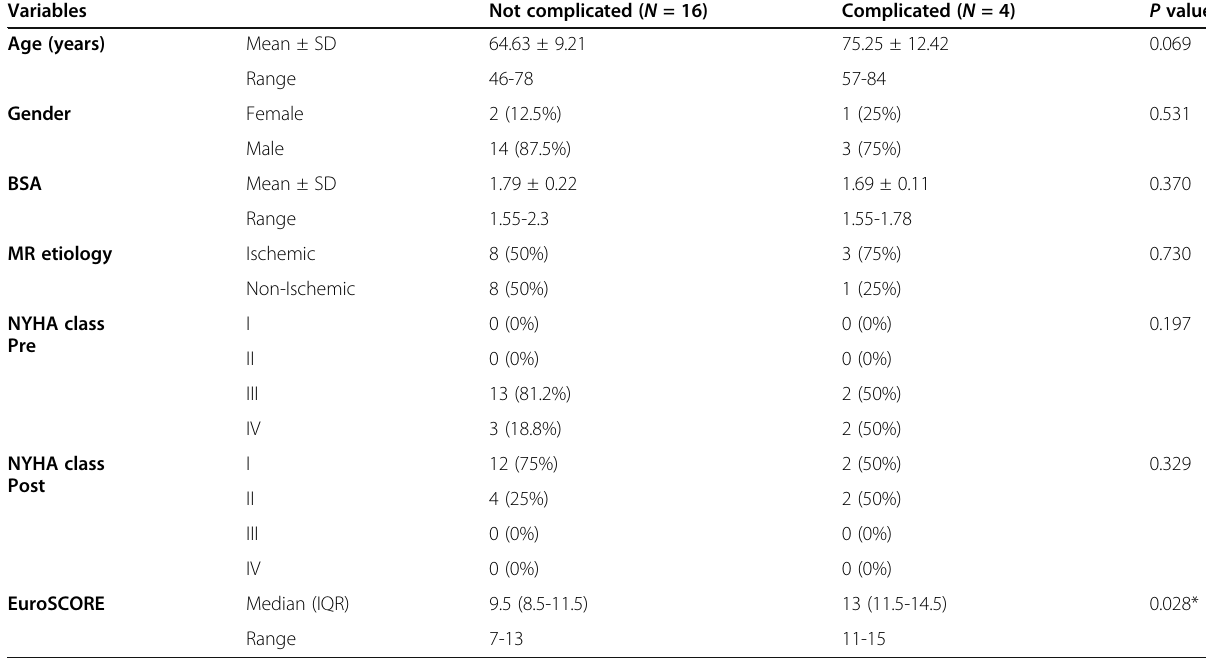
Table 5 Comparison between non-complicated and complicated groups for demographics Variables Not complicated ( N = 16)